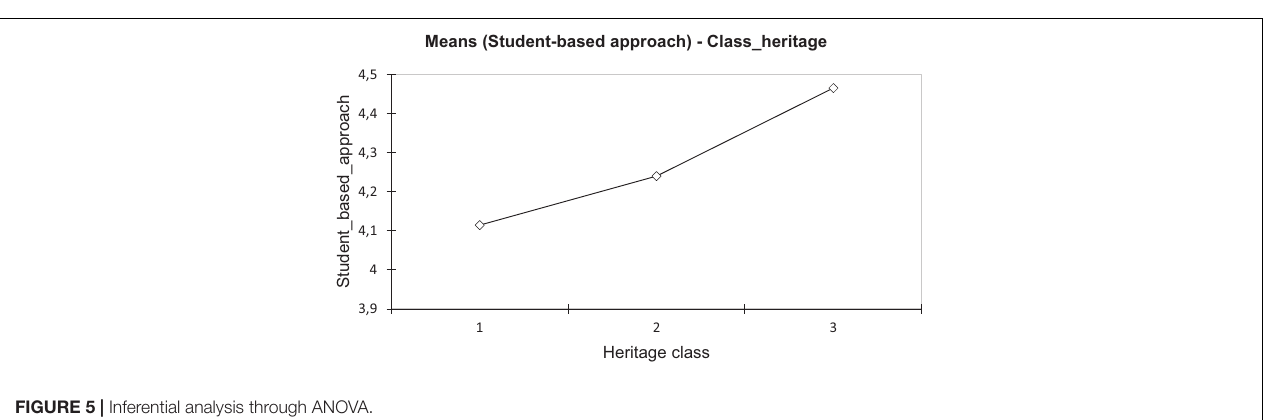
Means (Student-based approach) - Class_heritage